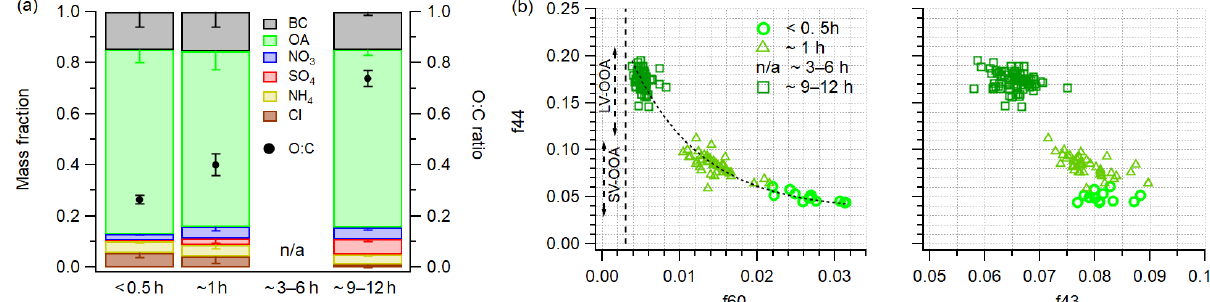
Figure 3. (a) The average chemical compositions of sampled smoke submicron aerosols at different ages (left axis); the black solid circles represent the average O : C ratios of OA in sampled smoke (right axis). The whiskers represent 1 standard deviation. (b) The fractional signals f 44 vs. f 60 and f 44 vs. f 43 of sampled smoke aerosols in our study. The dashed vertical line represents the background of f 60 (0.3%) in environments not influenced by BB, as recommended by Cubison et al. (2011). The dashed-dot line passing through measurement data indicates the general trend in f 44 vs. f 60 with aerosol age. Table 2. The ERs of BC and OA as well as some chemical information in sampled smoke. < 0.5h ∼ 1h ∼ 3–6h ∼